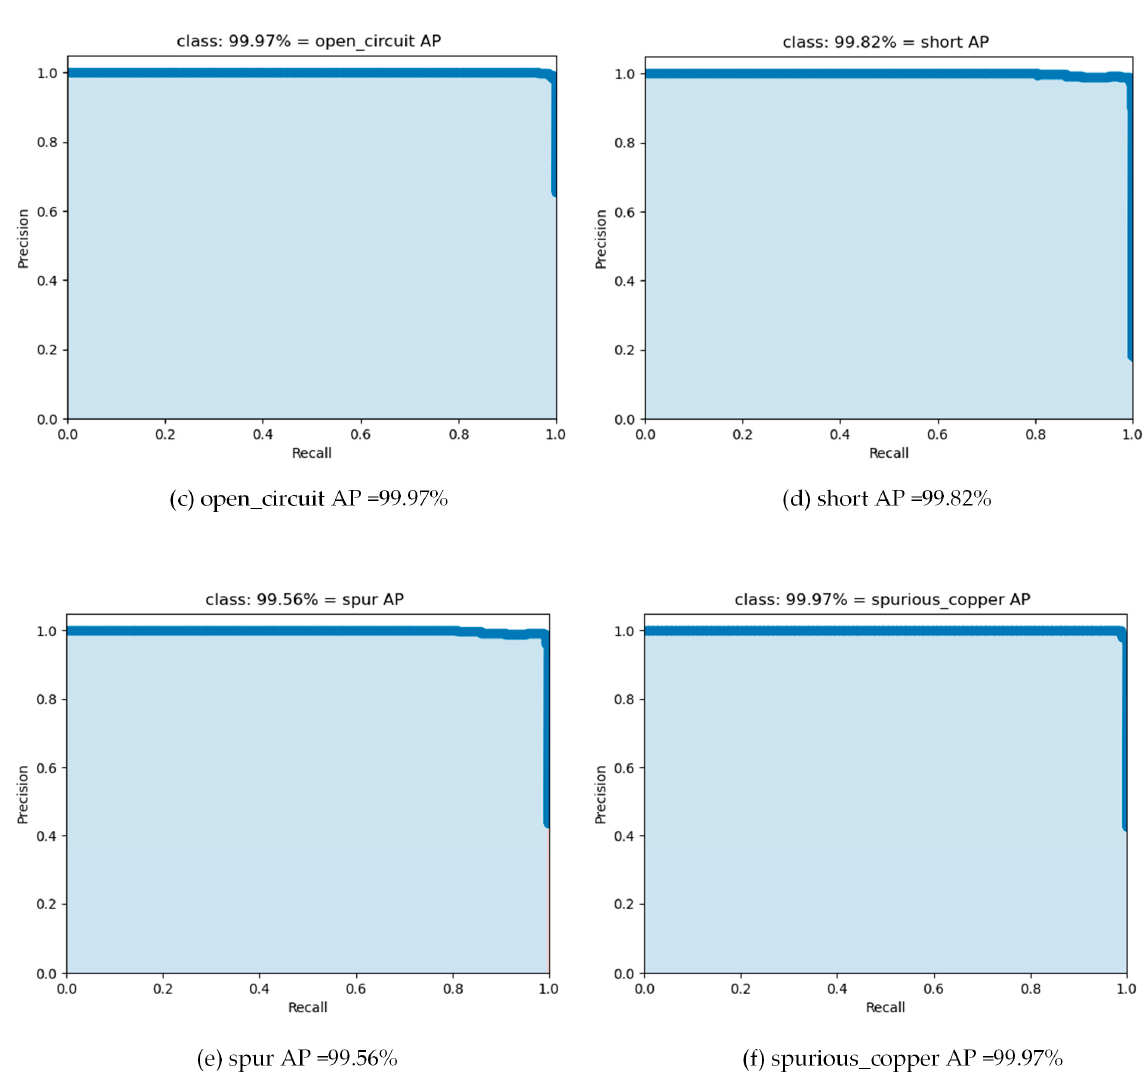
Figure 8. PCB defect precise recall (PR) curve at AP@0.5.